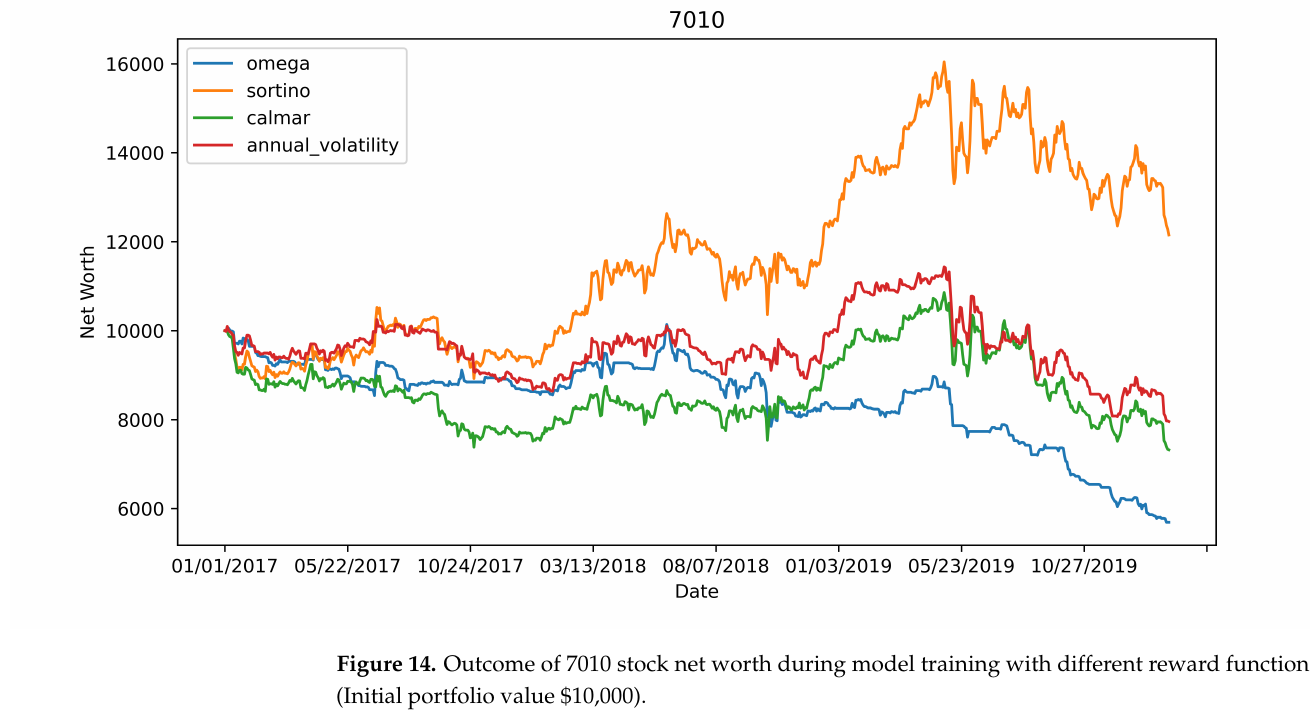
Figure 14. Outcome of 7010 stock net worth during model training with different reward functions (Initial portfolio value $10,000).